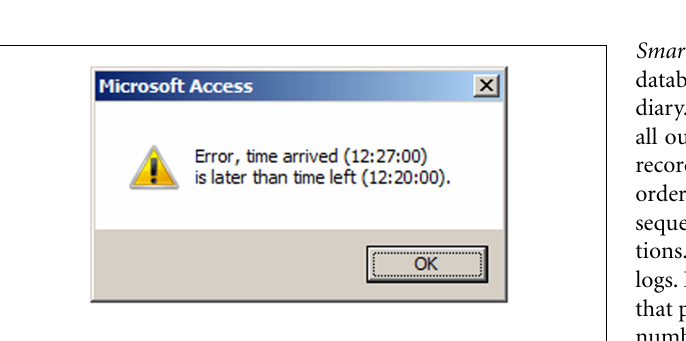
FIGURE 3 |Travel log database entry forms . Upper panel: common places; lower panel: a single place record.